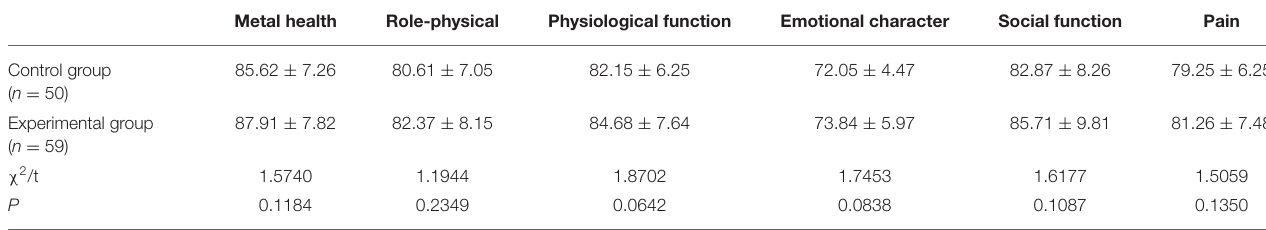
TABLE 8 | Comparison of quality of life of patients between the two